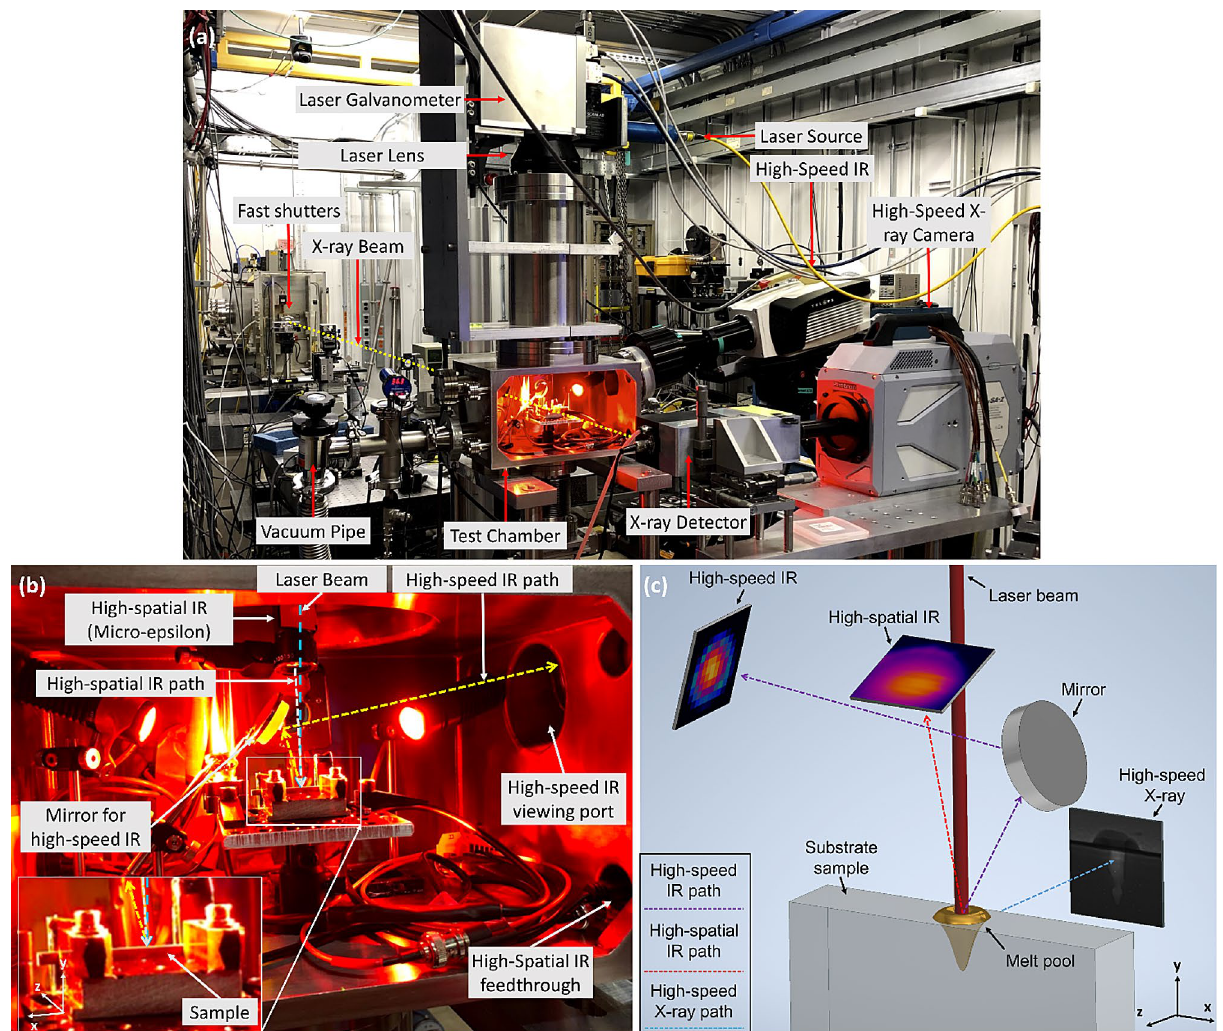
Figure 1. ( a ) The equipment layout of beamline 32-ID-B, APS, Argonne National Lab. ( b ) The layout of the testing chamber in beamline 32-ID-B, APS, Argonne National Lab that highlights the sensors used in this work. ( c ) The illustration of the viewing angle of high-speed X-ray, high-speed IR, and high-spatial IR. The aspect ratio has been